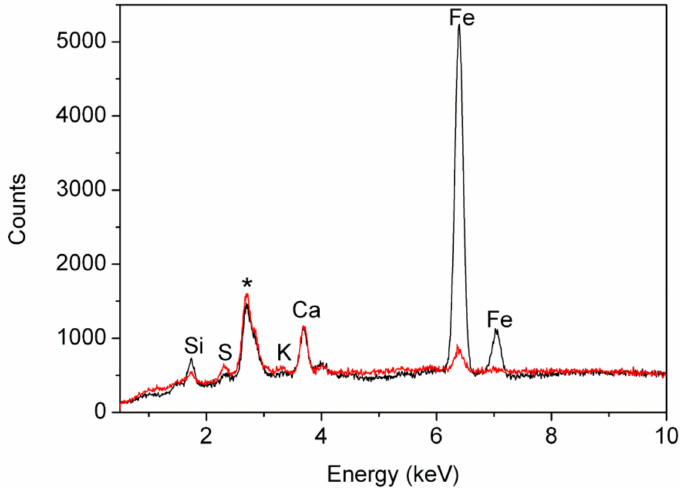
Figure 6. (Red) micro-XRF spectrum of sample BM2 selected as representative of samples dyed with organic dyes (madder or sa ffl ower); (black) micro-XRF spectrum of sample ME7, coloured with iron compounds. The peak marked with the asterisk arises from the Rh